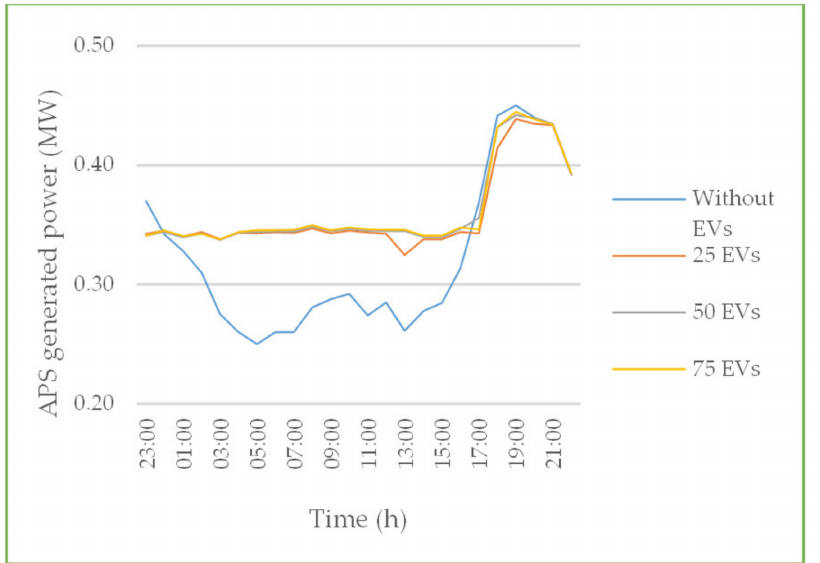
Figure 13. Autonomous power system (APS) output required in the presence of a 140.0 kWp PV plant for test case 2 and LC1.